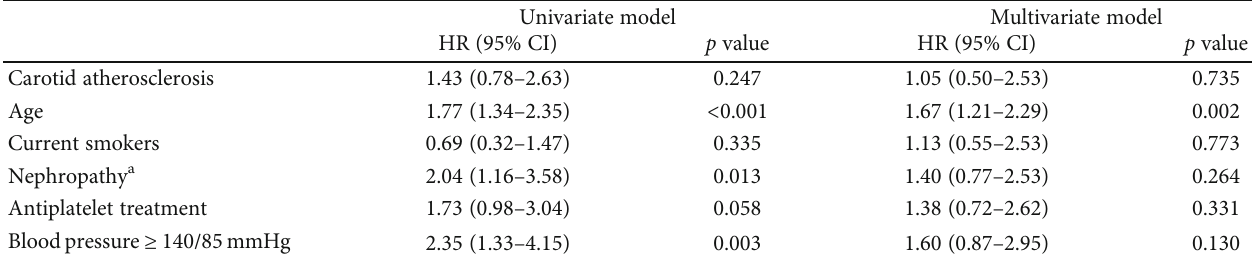
Table 2: Factors associated with new cardiovascular events in patients without prior cardiovascular events.